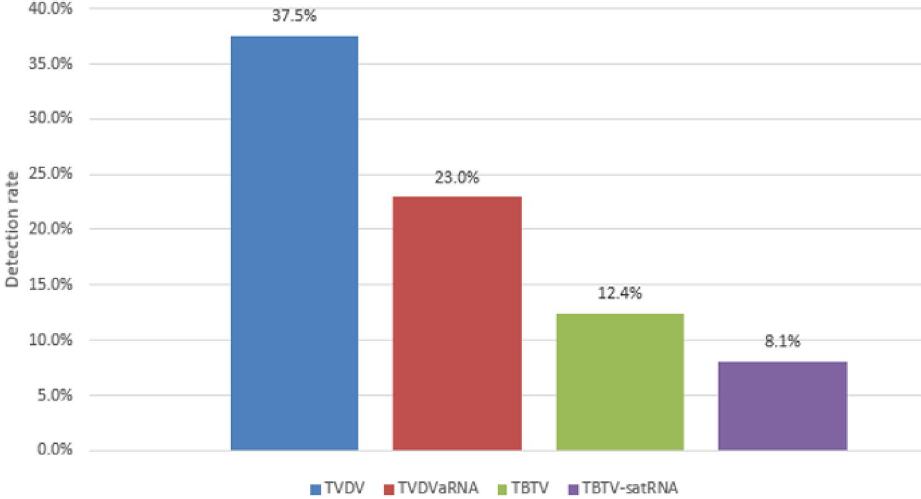
Figure 4. Detection rate of TBTV, TVDV, TBTVsatRNA and TVDVaRNA in field collected